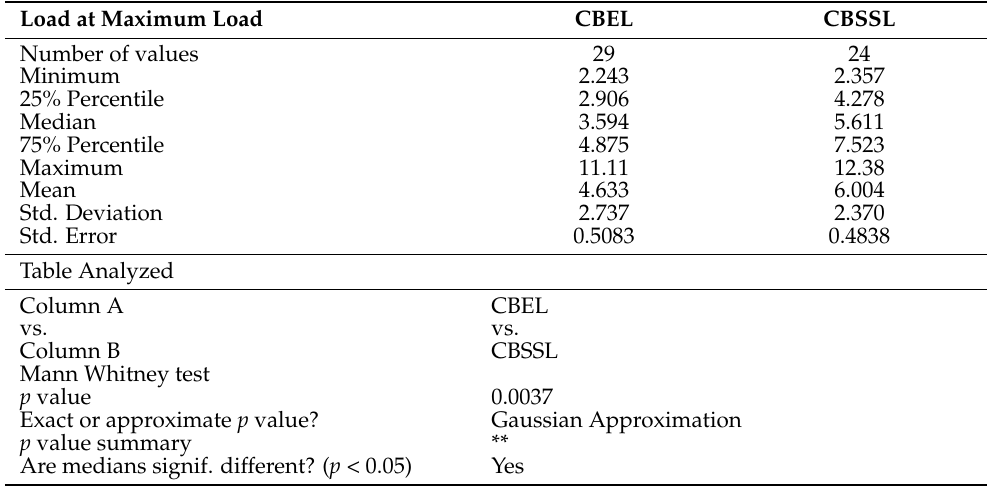
Table A10. Load at maximum load: conventional system elastic ligatures vs. stainless steel ligatures. Load at Maximum Load